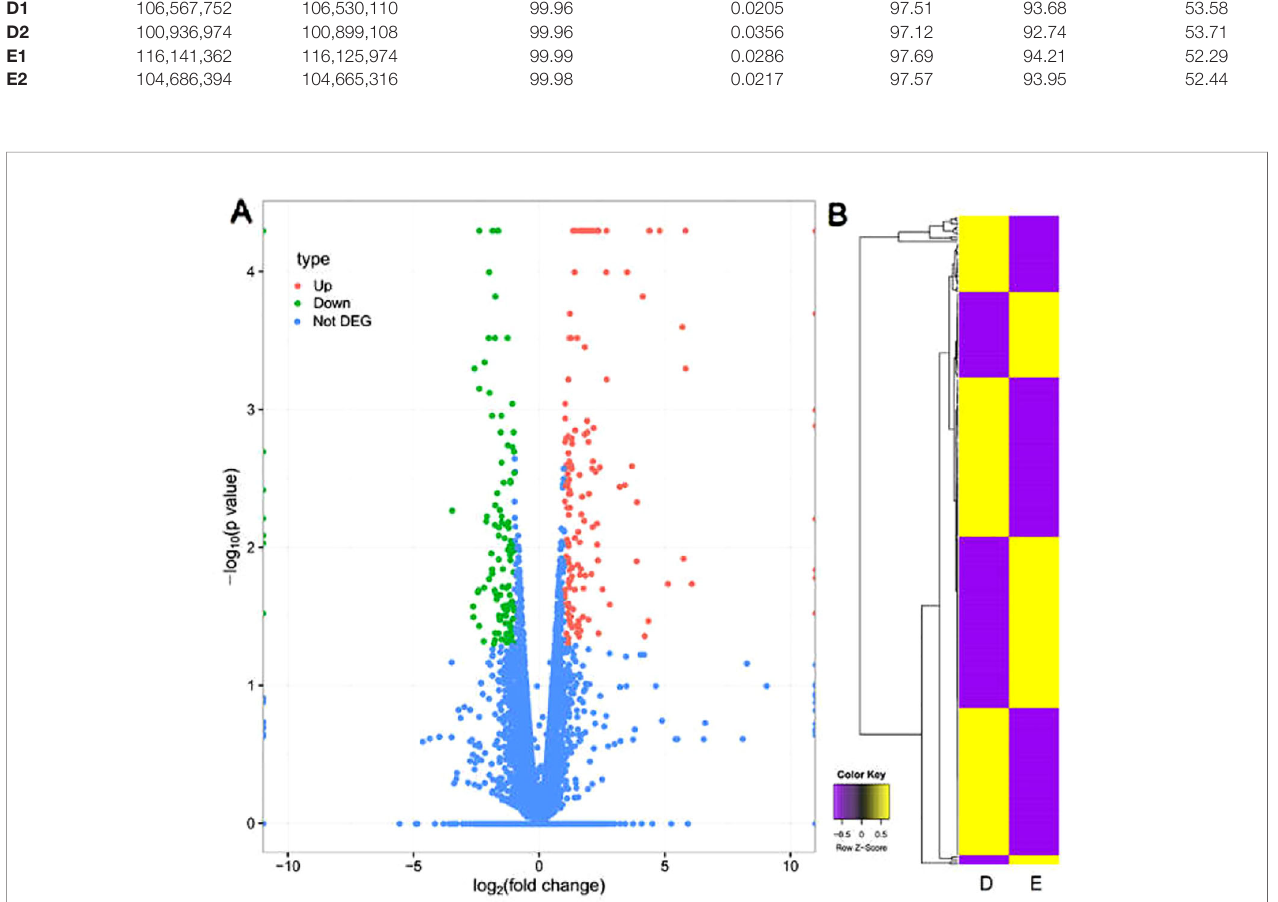
FIGURE 4 | The fi gure of DEGs. (A) Volcano plot of distribution trends for DEGs in group D and group E. The log 2 [fold change (group D/group E)] indicated the mean expression level for each gene. Each dot represented one gene. Red dots represented upregulated genes and green dots represented down-regulated genes. Blue dots represented genes with no differential expression. (B) Hierarchal clustering heat map of group D and group